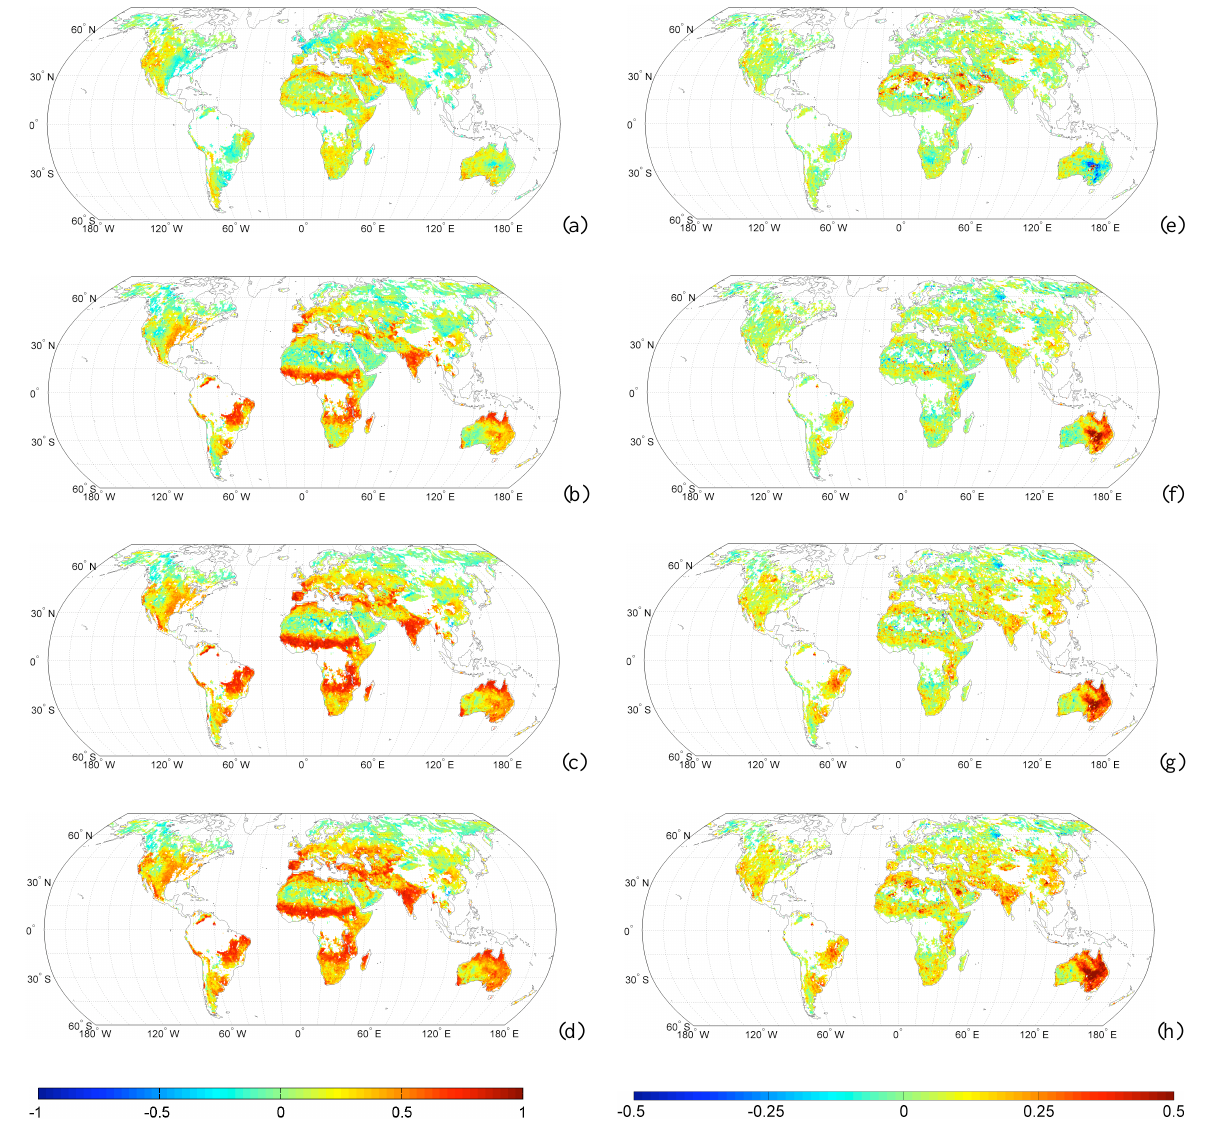
Fig. 1. (a) – (d) : Global correlation coefficient maps of AMSR-E (LPRM) versus the ORCHIDEE soil moisture parameters SHALLOW SM, DEEP SM, TOT SM and ROOT SM for the time period 2002–2010. (e) – (h) : Global correlation coefficient maps of the anomalies of AMSR-E (LPRM) versus the ORCHIDEE soil moisture parameters SHALLOW SM, DEEP SM, TOT SM and ROOT SM for the time period